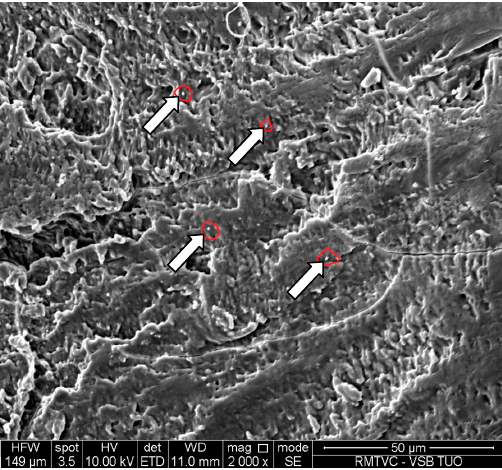
Figure 10. SEM image of risedronate with sodium carboxymethyl dextran (Sample 5c ) at magnification 2000×.